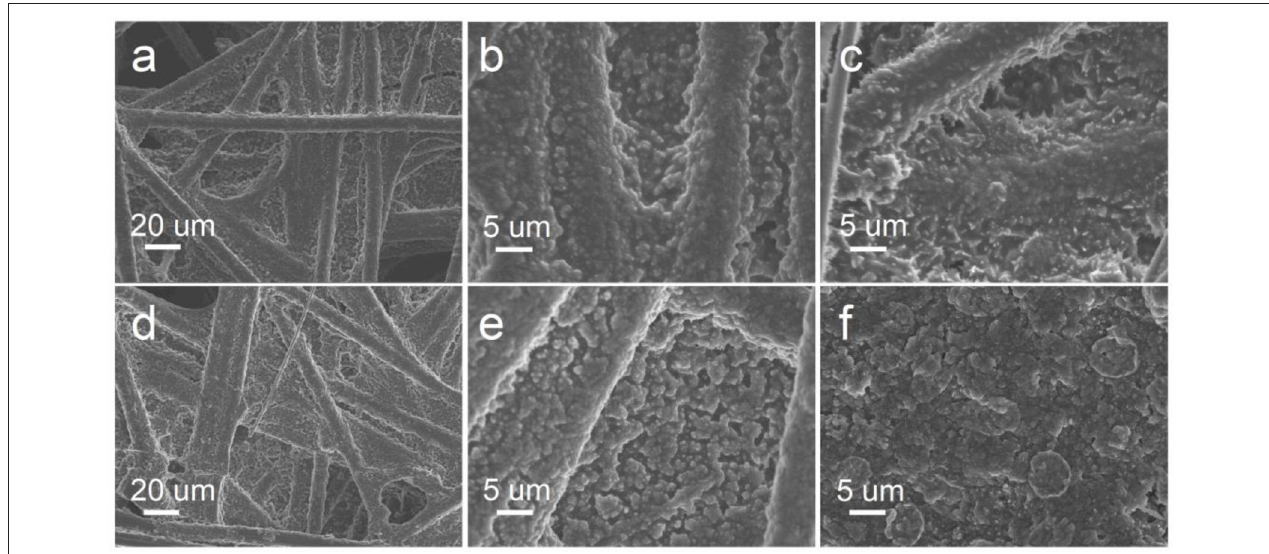
FIGURE 4 | Morphological evolution of the discharge products. (a) SEM image of MoS 2 − x after discharge to 500mA h g − 1 . (b) Enlarged view of (a) . (C) SEM image of MoS 2 − x after discharge to 1,000mA h g − 1 . (d) SEM image of MoS 2 after discharge to 500mA h g − 1 . (e) Enlarged view of (d) . (f) SEM image of MoS 2 after discharge to 1,000mA h g − 1 . Galvanostatic discharge with current at 500mA g − 1